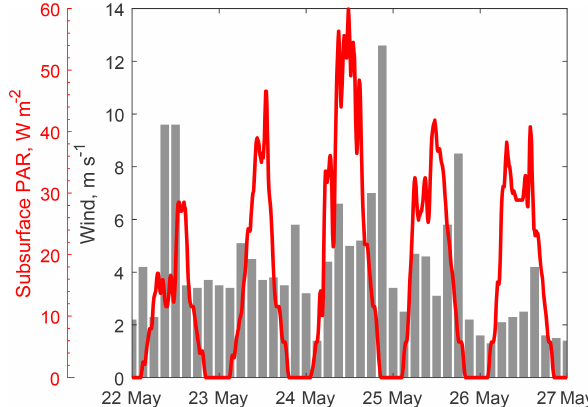
Figure 3. Wind (bars) and under-ice radiation (solid line) during the observation period.